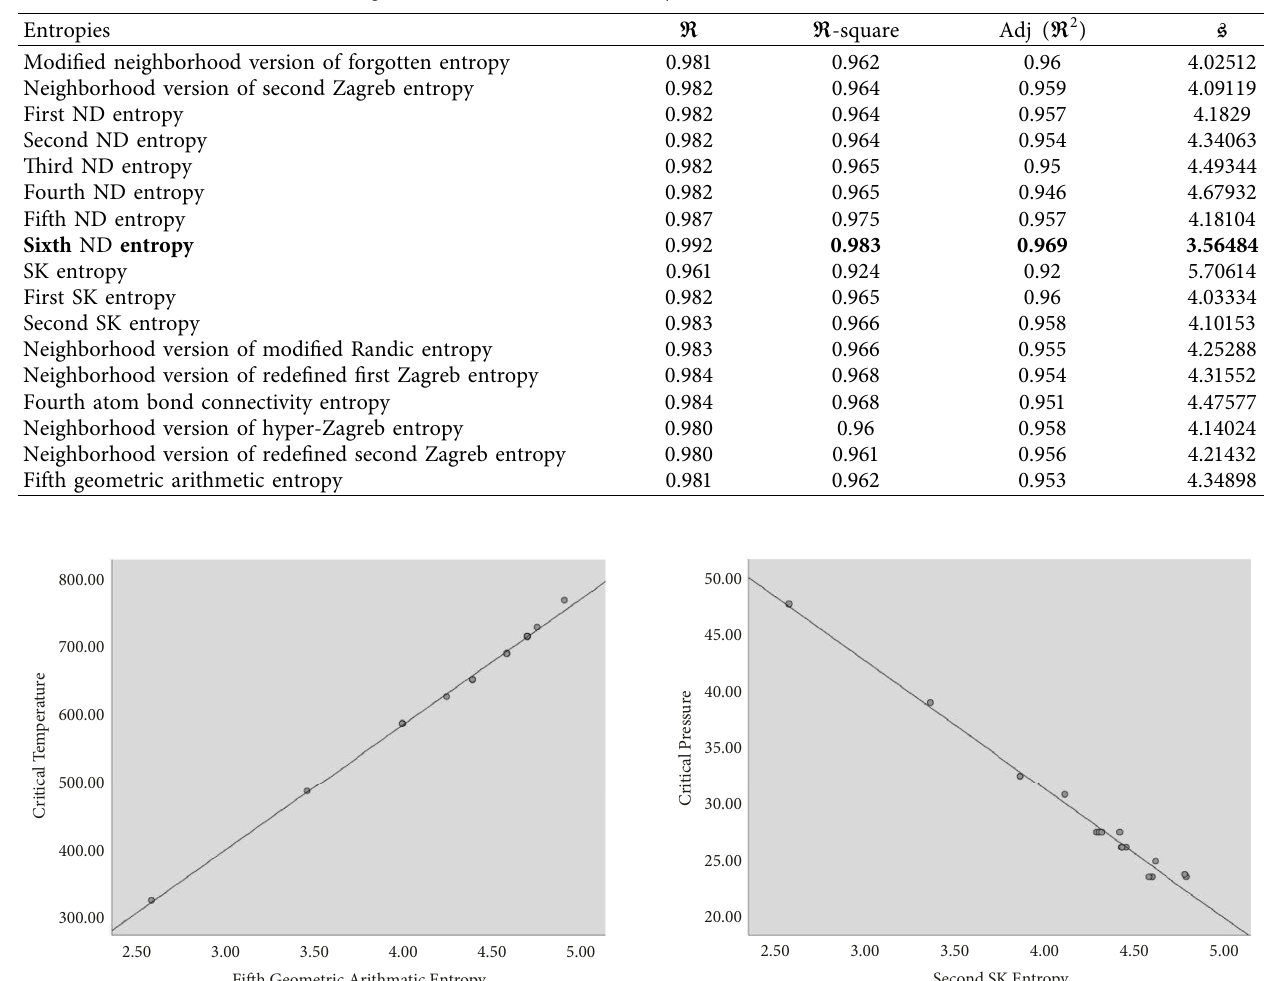
Table 9: The significant LRM: molar refractivity ( MR ) of benzene derivatives on indices.